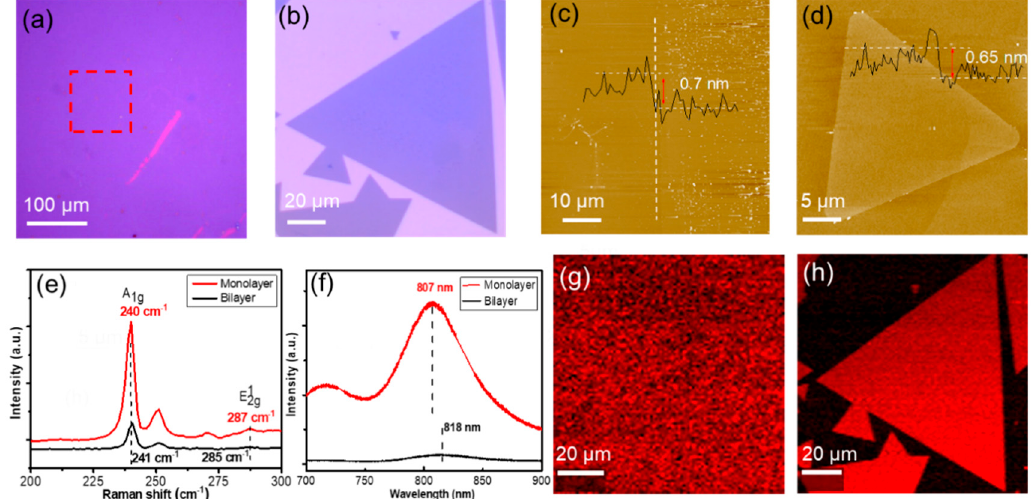
Figure 3. ( a ) The optical image of a monolayer MoSe 2 film grown on SiO 2 /Si substrate. ( b ) The optical image of a monolayer MoSe 2 flake. ( c , d ) atomic force microscope (AFM) topography of the